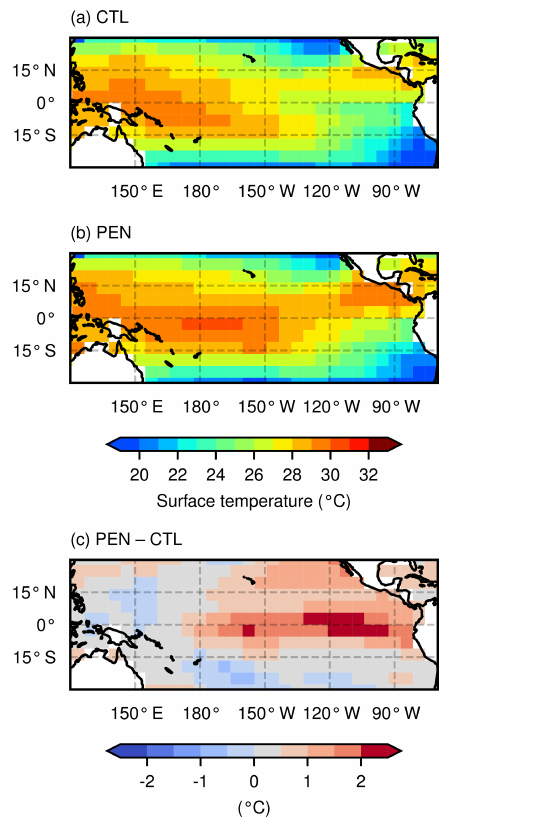
Figure 1. Annual mean of prescribed SST climatology in the equa- torial Pacific Ocean region for CTL (a) and PEN (b) simulations, and their absolute differences (c)